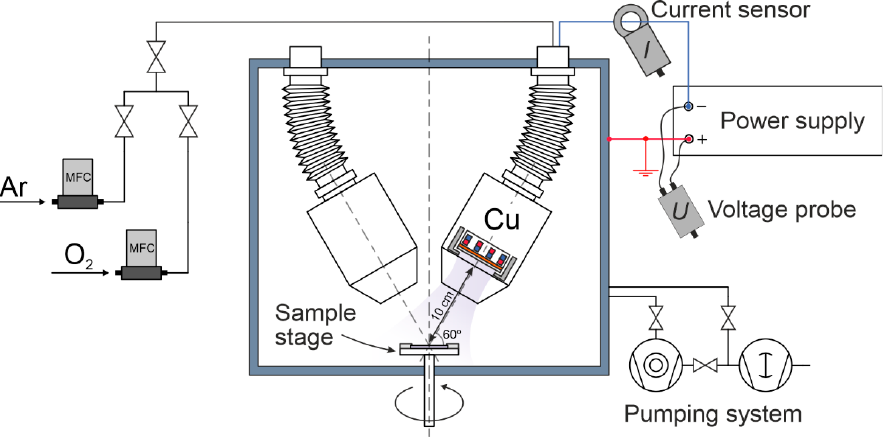
Figure 1. Conventional magnetron sputtering system with a cooled target.